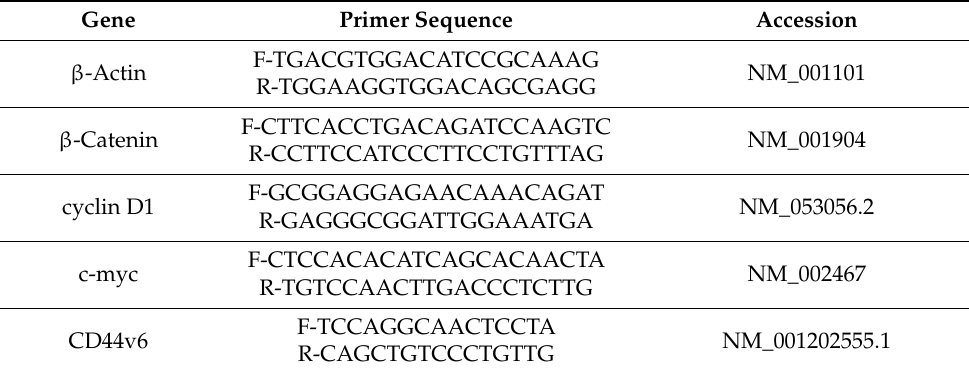
Table 1. Primers for PCR